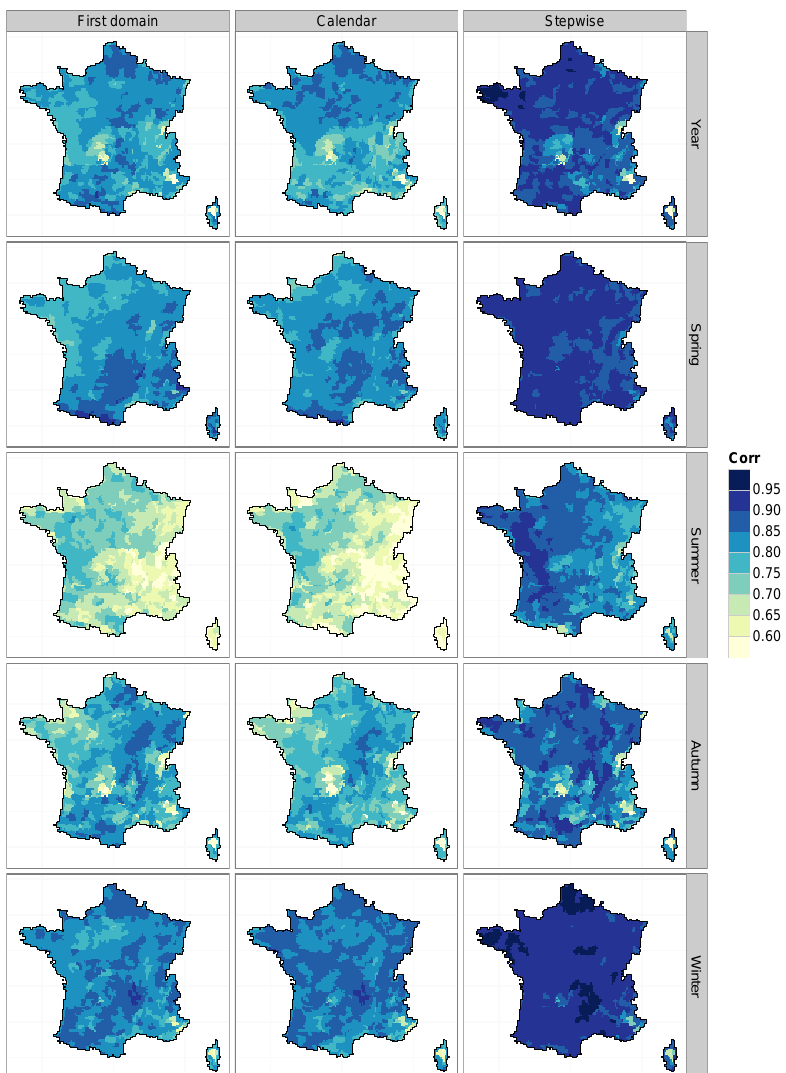
Figure 8. Median of the annual and seasonal temperature rank correlation between Safran all subselection methods for the 1959–2007 period. Minimum value of 0.35 for the first domain selection (year) and maximum value of 0.97 for the stepwise selection